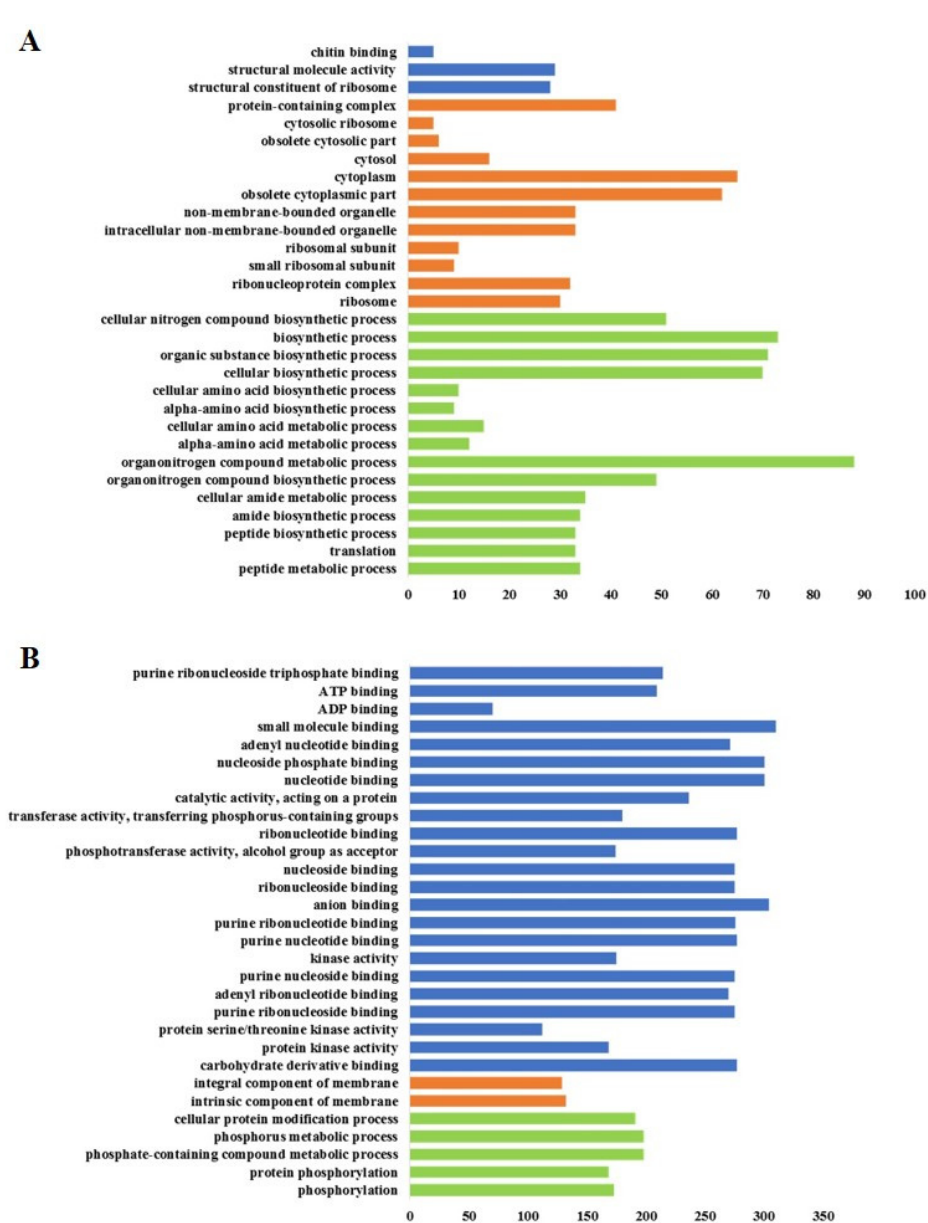
Figure 5. The GO enrichment histogram of co-upregulated and downregulated genes. The histogram intuitively reflects the distribution of the number of DEGs in GO terms enriched in BP, CC and MF. We selected the 30 GO terms with the most significant enrichment to show in the figures. The ordinate is the enriched GO term, and the abscissa is the number of differentially expressed genes in the term. Different colors are used to distinguish BP (green), CC (orange) and MF (blue). ( A , B ) respectively represent the GO enrichment of the upregulated genes and downregulated genes.